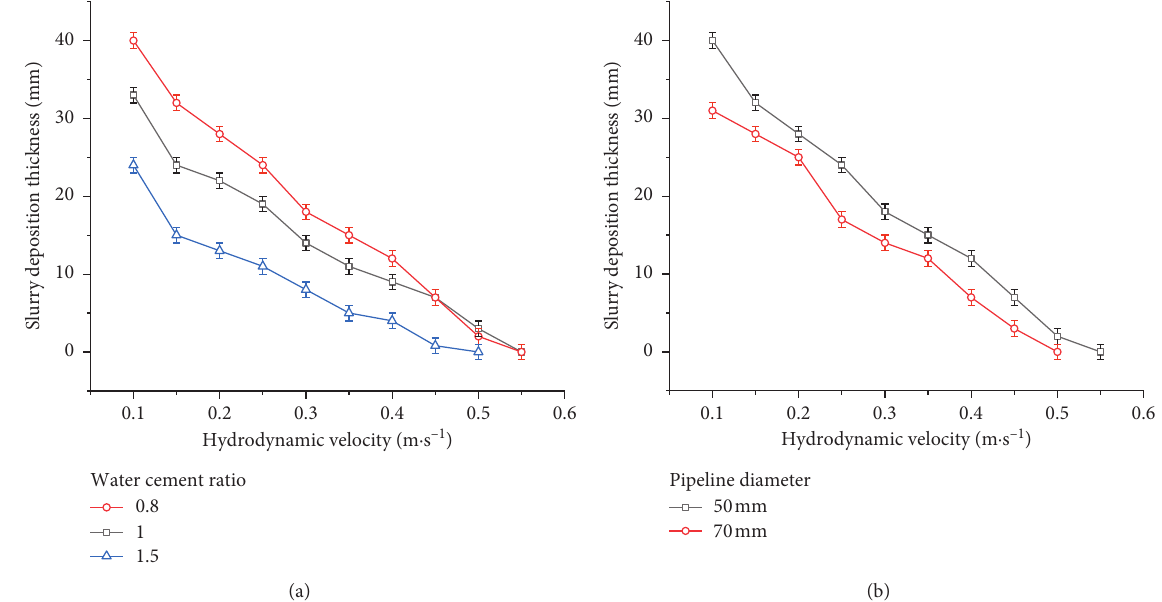
Figure 10: Analysis of test results of the optimal blocking flow rate.